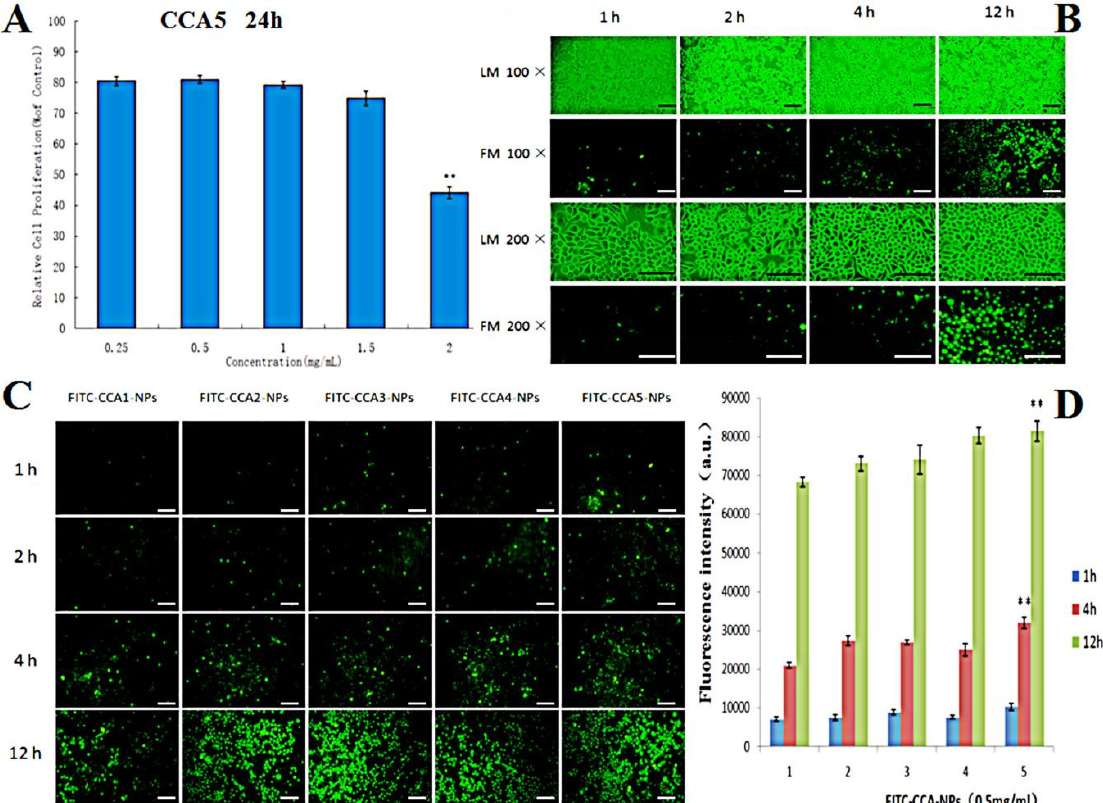
Figure 4. ( A ) Effects of CCA5-NPs on the proliferation ability of L929 cells (24 h), ** P < 0.01:2 mg/mL vs other concentrations; ( B ) Light microscopy (LM) and fluorescence microscope (FM) images of L929 cells treated with CCA5-NPsand FITC-CCA5-NPs: 1 h, 2 h,4 h and 12 h, the scale bar represents 25